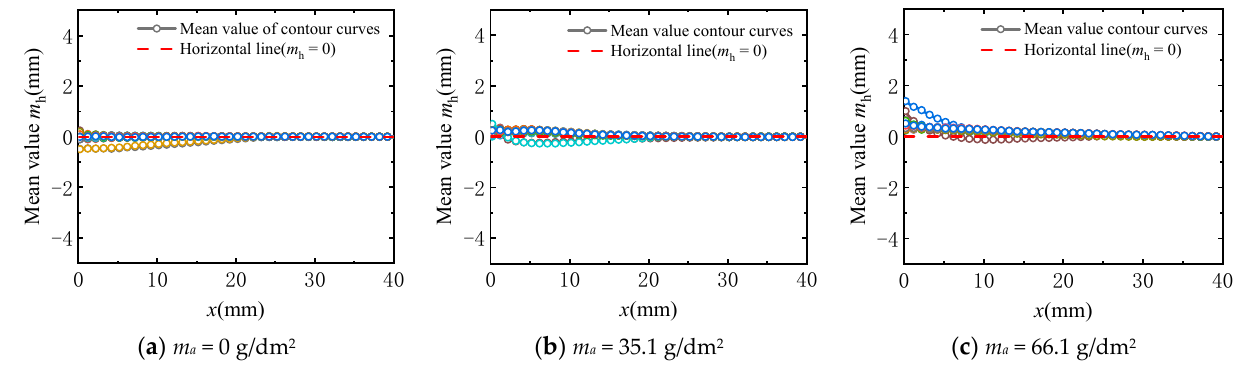
Figure 10. Mean value of surface height of two-dimensional contour curves.